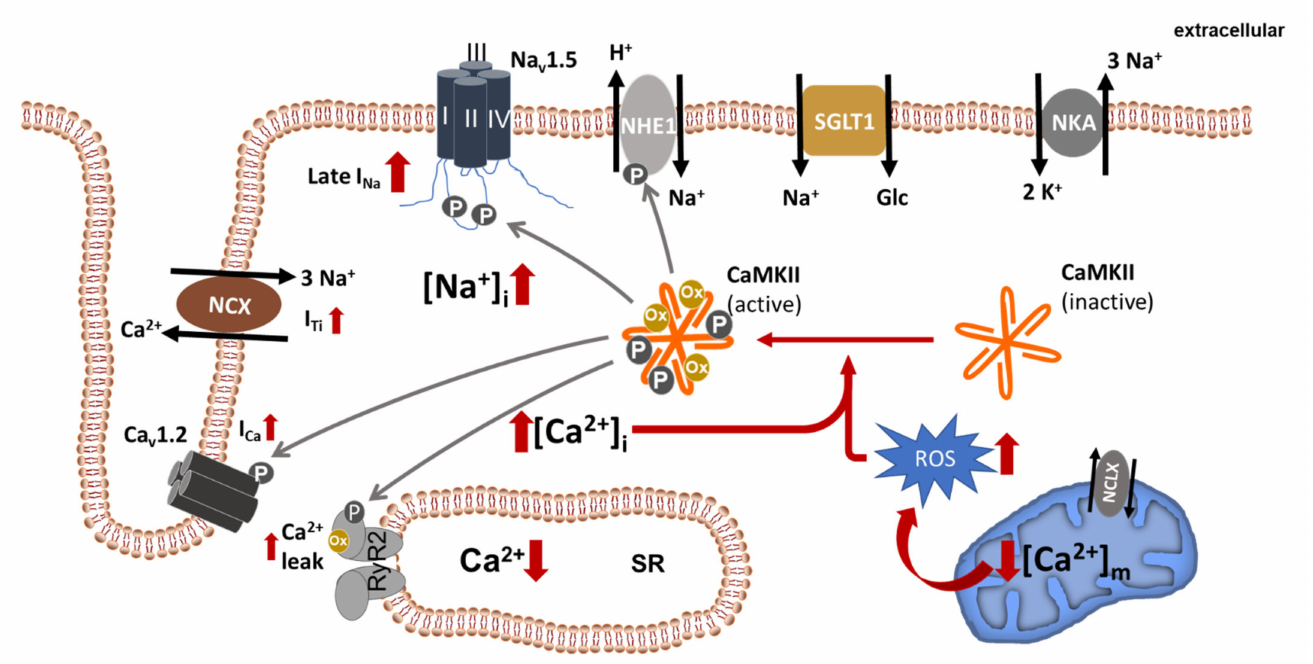
Figure 1. Dysregulated ion homeostasis in failing cardiomyocytes. Increased late I Na as well as increased forward mode NCX (constituting I Ti ), NHE1- and SGLT1 activity contribute to cellular Na + overload ([Na + ] i ). Na + overload, in turn, promotes cytosolic Ca 2+ overload ([Ca 2+ ] i ) and mitochondrial Ca 2+ depletion ([Ca 2+ ] m ) (with increased ROS generation), both of which are able to activate CaMKII, which is centrally involved in the regulation of multiple Na + and Ca 2+ channels/transporters. The solid grey lines indicate known CaMKII phosphorylation targets. NKA, Na + /K + ATPase; RyR2, ryanodine receptor 2; SR, sarcoplasmic reticulum; NCX, Na + /Ca 2+ exchanger; NCLX, mitochondrial Na + /Ca 2+ exchanger; ROS, reactive oxygen